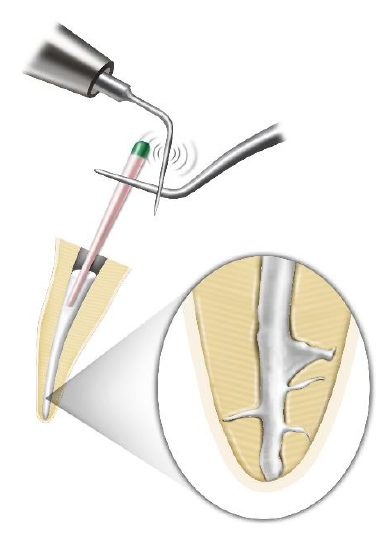
Figure 2. Illustration of the ultrasonic-mediated activation for the main and accessory canal fillings.